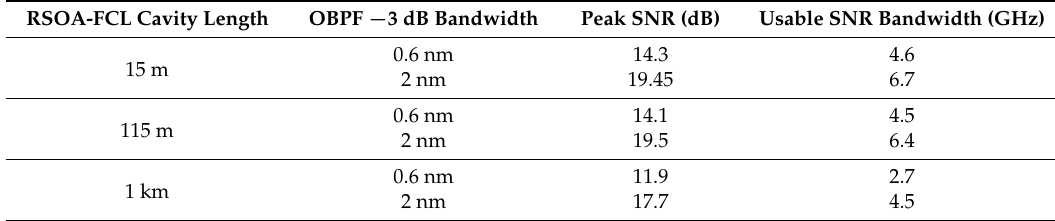
Table 1. Summary of results to compare the peak signal-to-noise ratio (SNR) and usable SNR bandwidth for the RSOA-FCL (reflective semiconductor optical amplifier fiber cavity laser) with 0.6 nm or 2 nm filter bandwidths. For both filters, the fiber cavity length varied between 15 m, 115 m and 1 km. OBPF: optical band-pass filter.